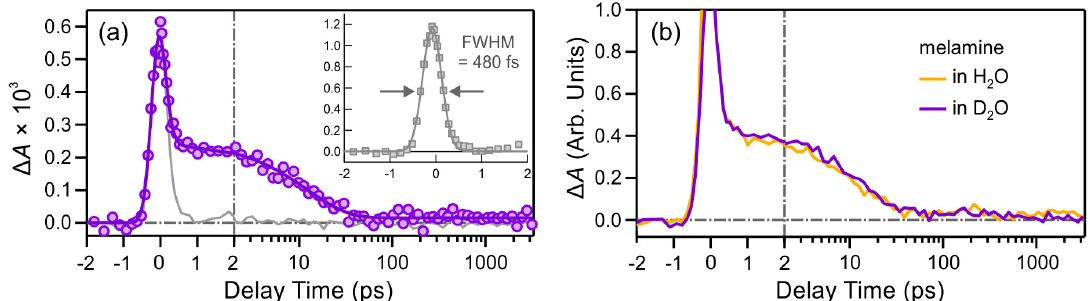
Figure 4. ( a ) Excited-state decay of melamine in neutral D 2 O solution probed at 350 nm after 240 nm excitation. The purple points are experimental data. The solid line is the best-fit curve A 0 δ ( t ) + A 1 e − t / τ 1 + A 2 , see text. The solid gray line is the instrument response function obtained from pure D 2 O. The fwhm of this signal is 480 fs (inset); ( b ) Excited-state decay of melamine in neutral H 2 O ( orange ) and D 2 O ( purple ) solutions. The solid lines are experimental data.